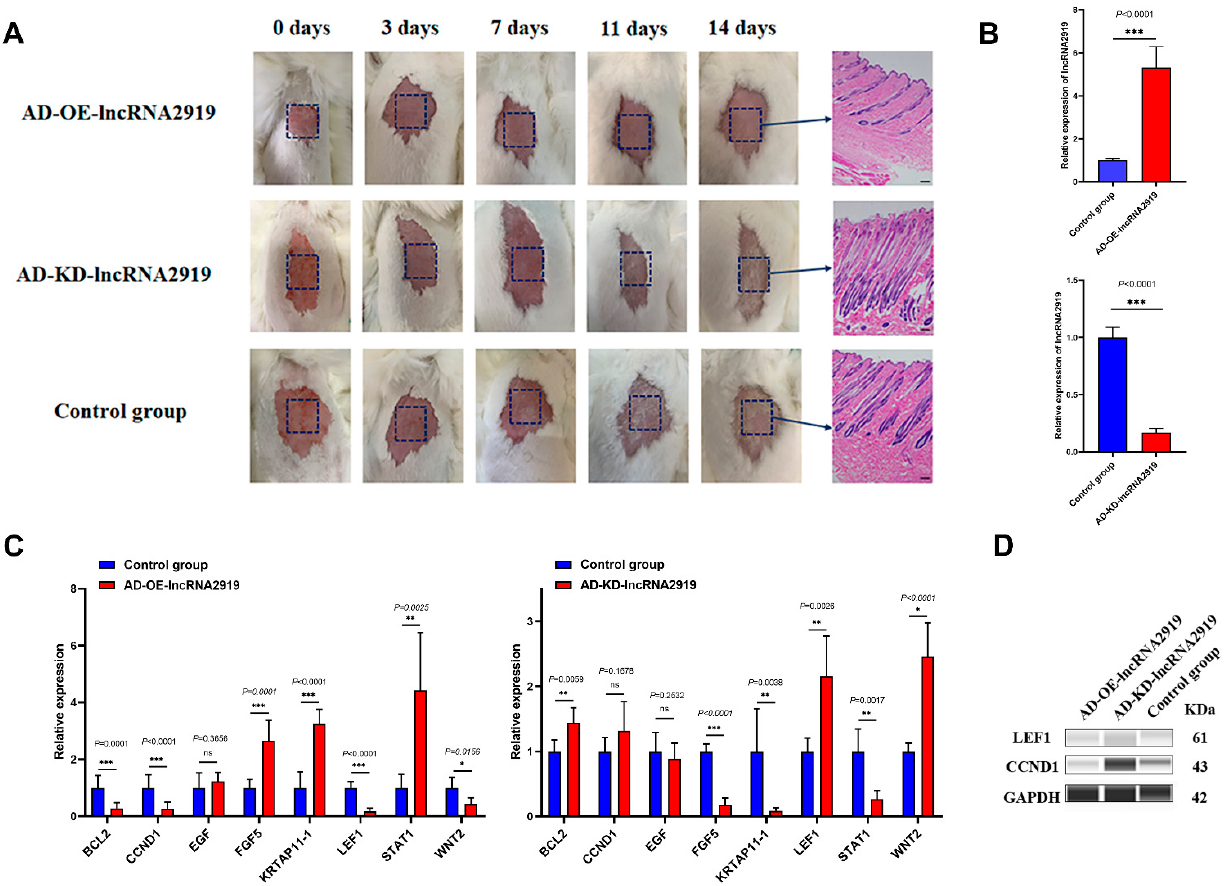
Figure 2. AD-lncRNA2919 regulates HF regeneration in Angora rabbits. ( A ) Morphological observa- tion of rabbit skins after subcutaneous injection in the AD-OE-lncRNA2919, AD-KD-lncRNA2919, and control groups. Scar bar = 200 µ m. ( B ) lncRNA2919 expression in AD-OE-lncRNA2919 and AD- KD-lncRNA2919 after the subcutaneous injection of adenovirus in Angora rabbits. ( C ) lncRNA2919 regulated the HF cycle- and growth-related genes in Angora rabbits. ( D ) lncRNA2919 regulated the HF cycle- and growth-related proteins in Angora rabbits. Data are presented as mean ± SEM. The two-tailed paired t -test was used for data analyses. For significance, * p < 0.05, ** p < 0.01, *** p < 0.001, ns indicates not significant.